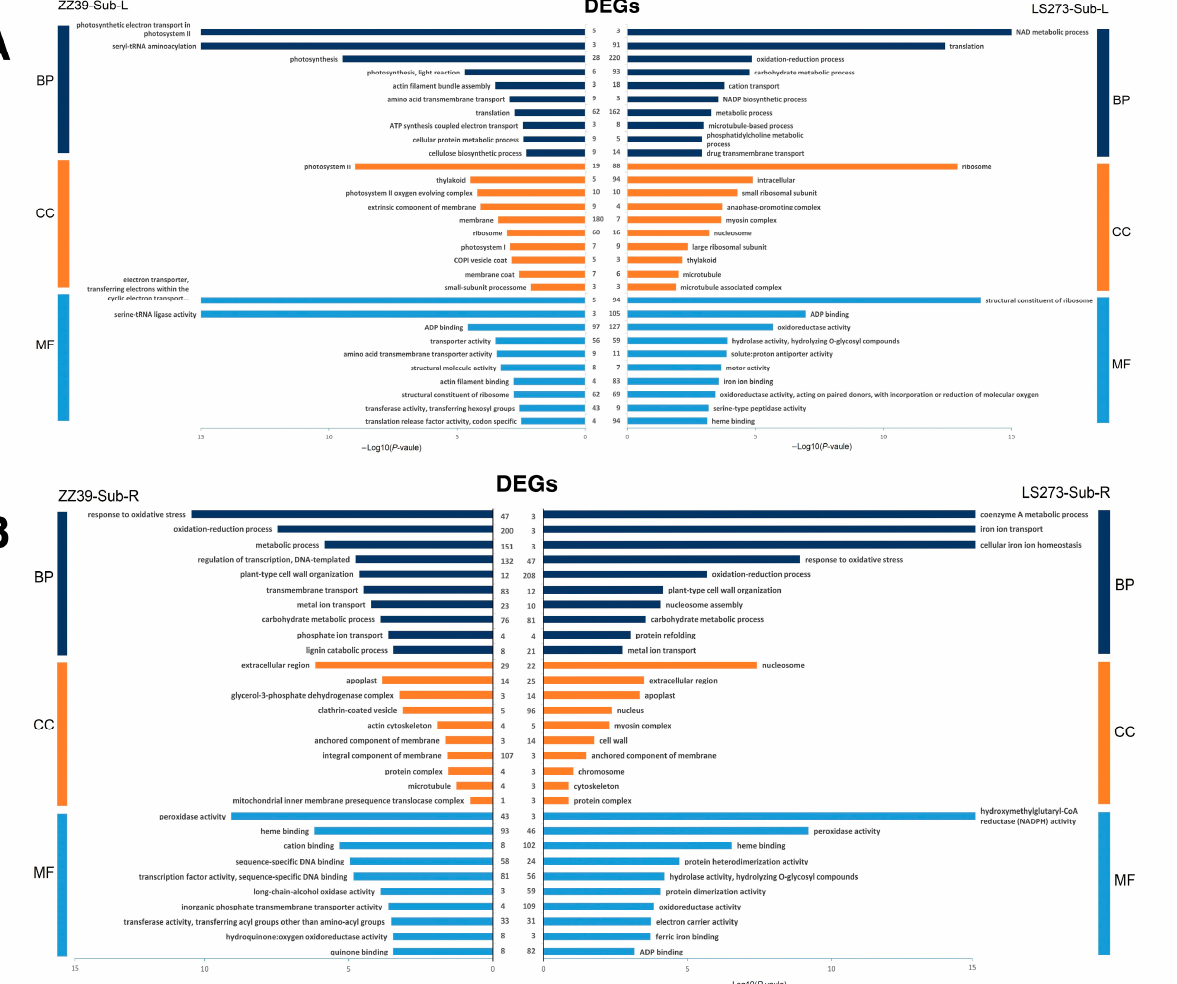
Figure 6. GO enrichment under submergence stress and expression of DEGs under the antioxidant system. ( A ) The enrichment results of DEGs in shoots; ( B ) the enrichment results of DEGs in roots; ( C ) enrichment results of shared DEGs in shoots and roots; ( D ) expression of DEGs in antioxidant enzyme system; ( E ) expression of DEGs in glutathione cycle. BP: Biological Process; CC: Cell Com- ponent; MF: Molecular Function; I, II, II and IV: Cluster analysis type.